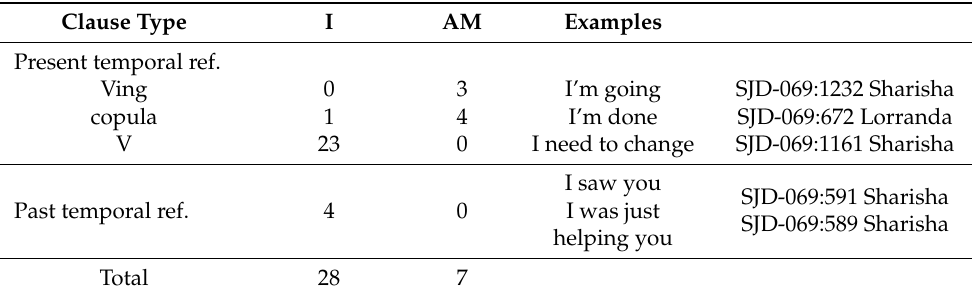
Table 1. Distribution of 1sg subject pronouns by main verb